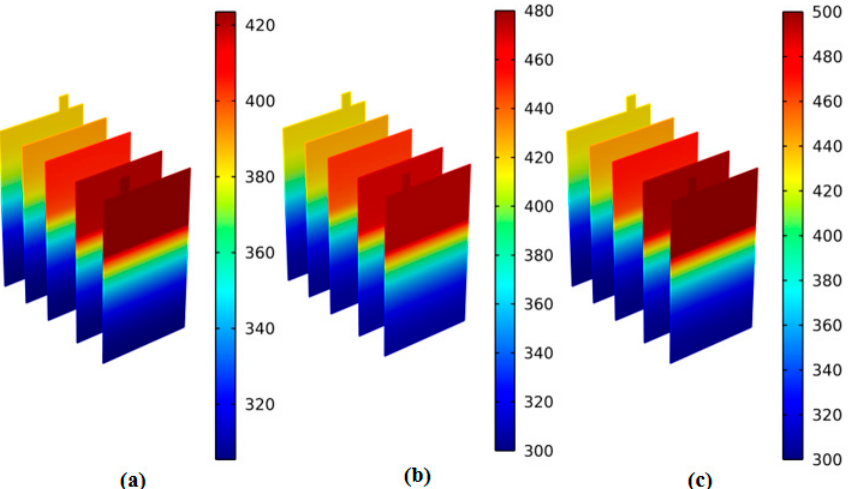
Figure 4. Temperature distribution curves for each part of the cell in tests 4, 5, and 6, for 300 s ( a ) 423.15 K; ( b ) 473.15 K; and ( c ) 523.15 K.